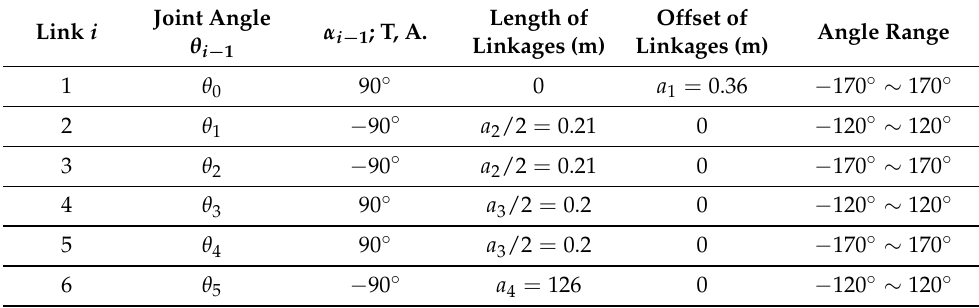
Table 8. D-H parameters of the KUKA 6 DOF